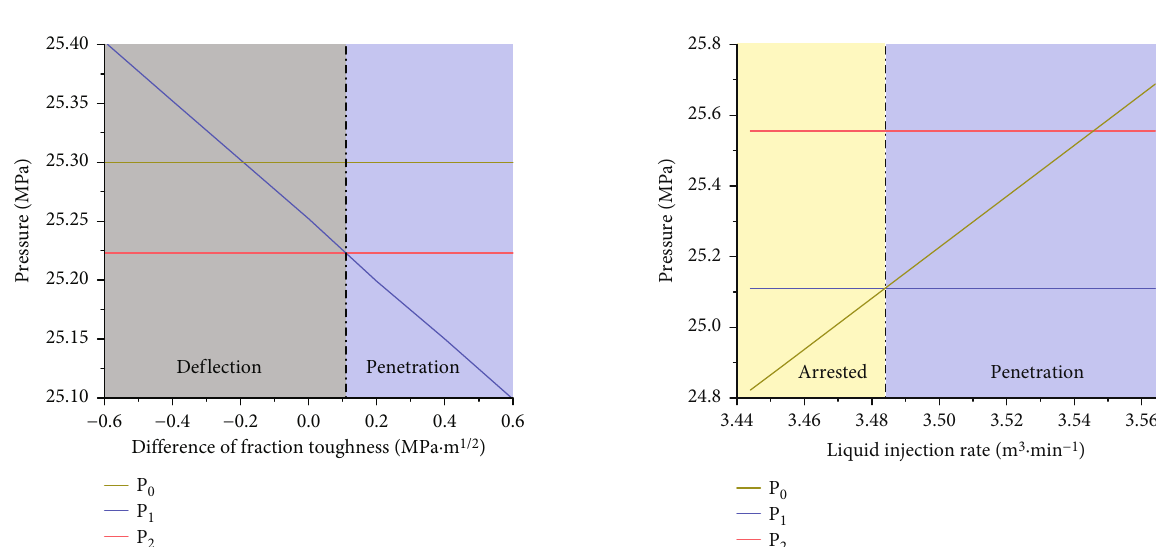
Figure 6: Changes in P 0 , P 1 , and P 2 with injection